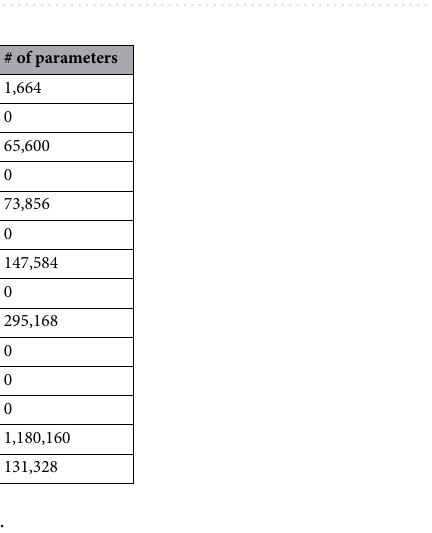
Figure 3. Structure of the designed CNN: B, block; FC, fully connected layer. A series of blocks which consist of a convolutional layer and a max pooling layer extract features describing the input object. The extracted features are classified through two FC layers, also referred to as dense layers. Finally, a spatial mode of the input is determined by a softmax activation function included in the last FC layer.